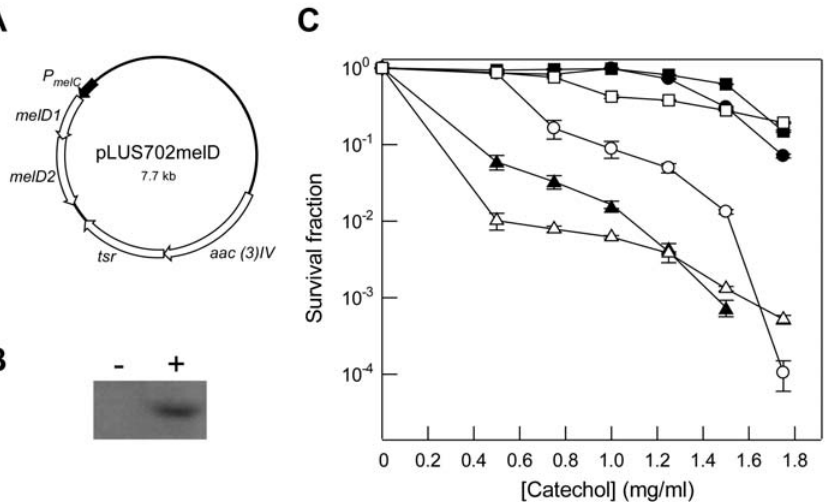
Figure 5. Complementation and additivity studies. A. Complementation vector pLUS702melD. This plasmid is derived from pIJ702-117, the melC operon of which was replaced by the melD operon of S. coelicolor with a C-terminal his6-tagged melD2 (as in HY2), and the apramycin resistance gene inserted. B. Expression of melD on pLUS702melD. An overnight culture of S. lividans /pLUS702melD in TSB was collected and sonicated, and the proteins separated by SDS-PAGE. The presence of His6-tagged MelD2 was detected by immunoblot using anti-polyhistidine antiserum. ‘-’ S. lividans 1326; ‘ + ’, S. lividans 1326 harbouring pLUS702melD. C. Effect of genetic complementation and additivity. The sensitivity test was performed as in Fig. 4. Filled circles, M145; open circles, HY69; filled triangles, M145/pIJ702-117; open triangles, HY69/pIJ702-117; filled squares, M145/pLUS702melD;